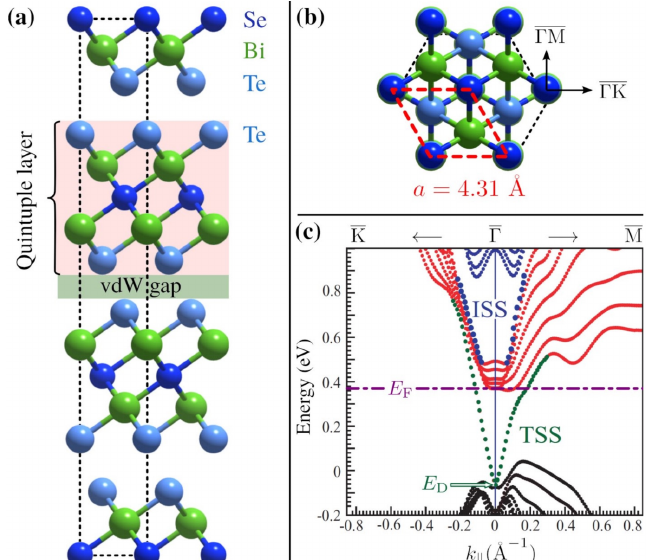
Figure 1. ( a ) Side view of the conventional hexagonal unit cell of Bi 2 Te 2 Se. The unit cell consists of three quintuple layers, each of which is terminated by a Te layer. ( b ) The (111) cleavage plane, according to rhombohedral notation, with the red rhombus highlighting the hexagonal surface unit cell of the (0001) plane in hexagonal notation. ( c ) Surface band structure of Bi 2 Te 2 Se(111) calculated by Nurmamat et al. [25] (reproduced with permission, copyright 2013 by the American Physical Society) along the symmetry directions Γ K and Γ M. TSS labels the topological surface states forming the Dirac cone, while internal (quantum-well) surface states (ISS) are also found in the gap above the conduction band minimum. In the present sample, the Fermi level E F (purple dash-dotted line) is located about 0.43eV above the Dirac point E D and 0.37eV above the Fermi energy, i.e., the zero ordinate in